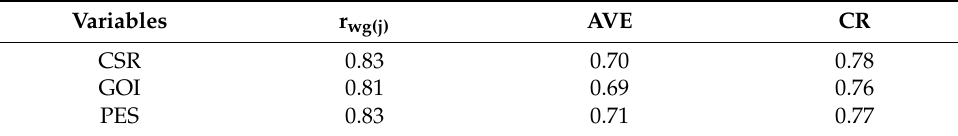
Table 1. The r wg(j) , average variance extracted, and composite reliability.